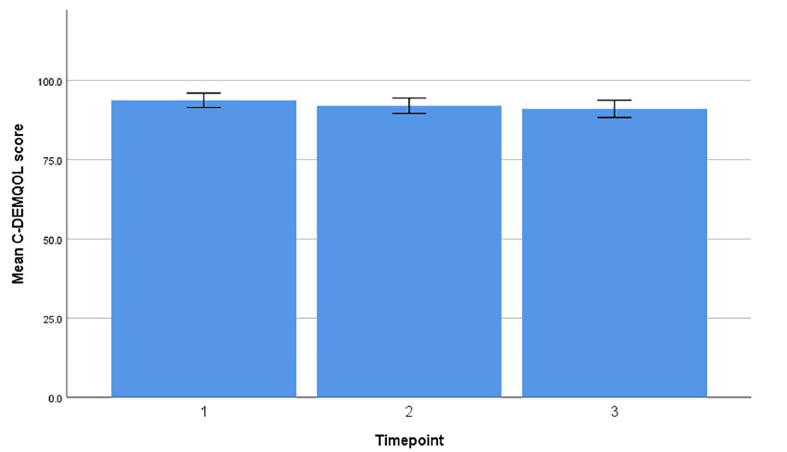
Fig 2. Timeline and change in mean scores